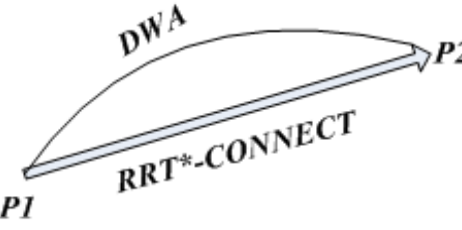
Figure 11. Diagram of fusion algorithm.